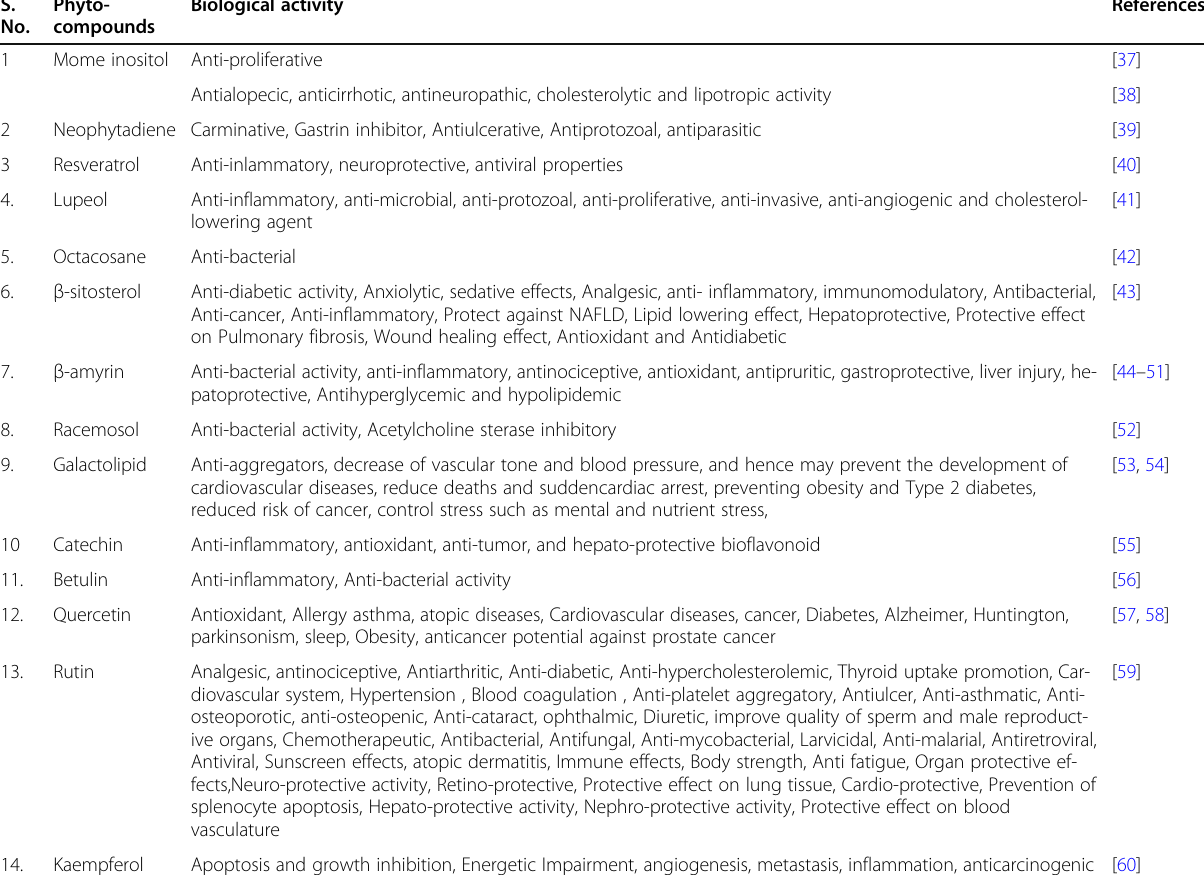
Table 4 Pharmacological applications of those identified molecules